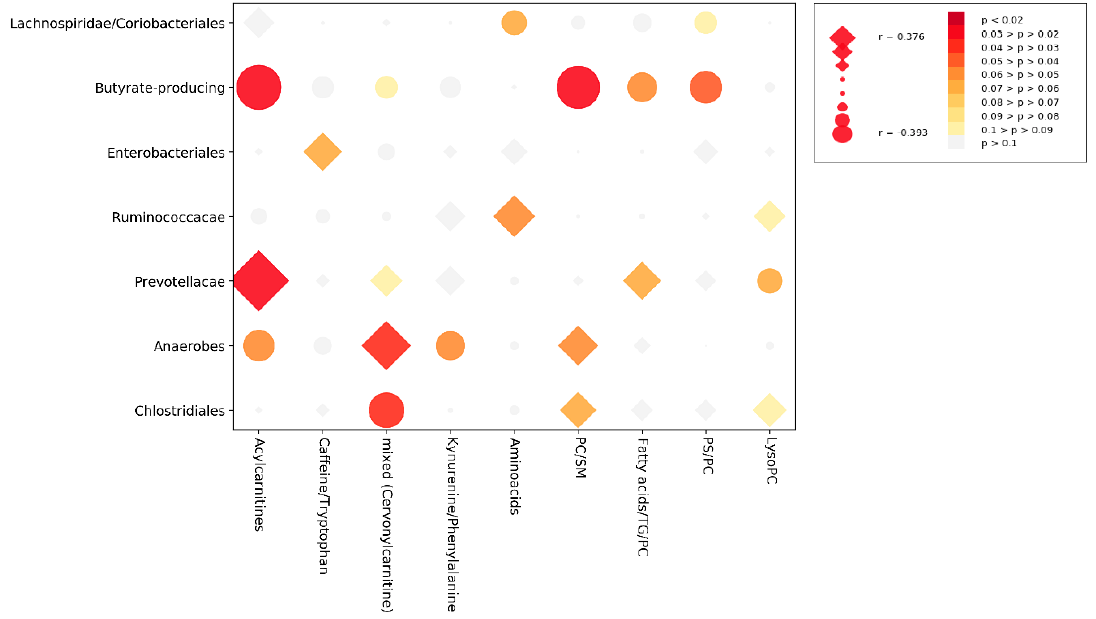
Figure 3. Simplified cross-correlation. Partial correlation analysis of aggregated microbiome and metabolome data after correction for confounding variables (age, hydroxycloroquine, steroid and immunosuppressant use). Aggregated clusters are calculated from the full correlation matrix shown in Supplementary Figure S7, as described in the methods and manually annotated. Note: Diamonds, positive partial correlations; circles, negative partial correlations; p values assessed after permutation testing.